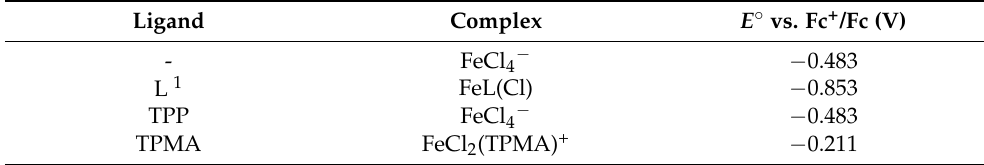
Table 1. Standard reduction potentials of Fe(III) complexes in DMF + 0.1 M Et 4 NBF 4 at T = 25 ◦ C. Ligand